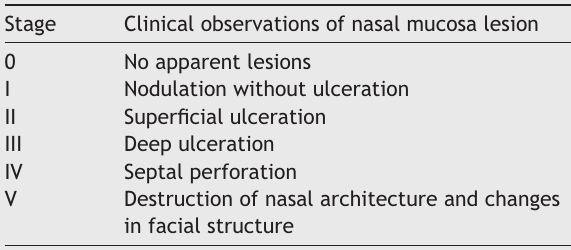
Staging of nasal mucosa